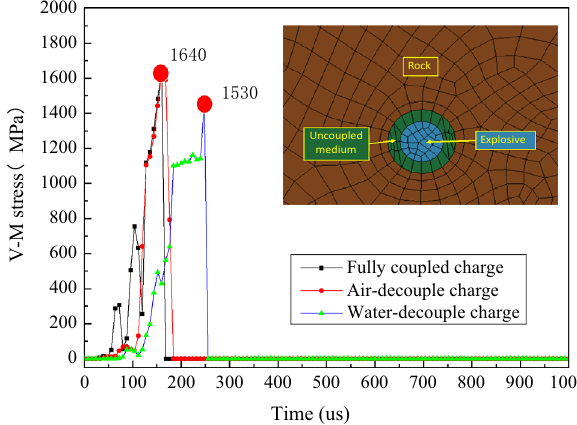
Fig. 6 Impact stresses on the hole wall under different charging conditions